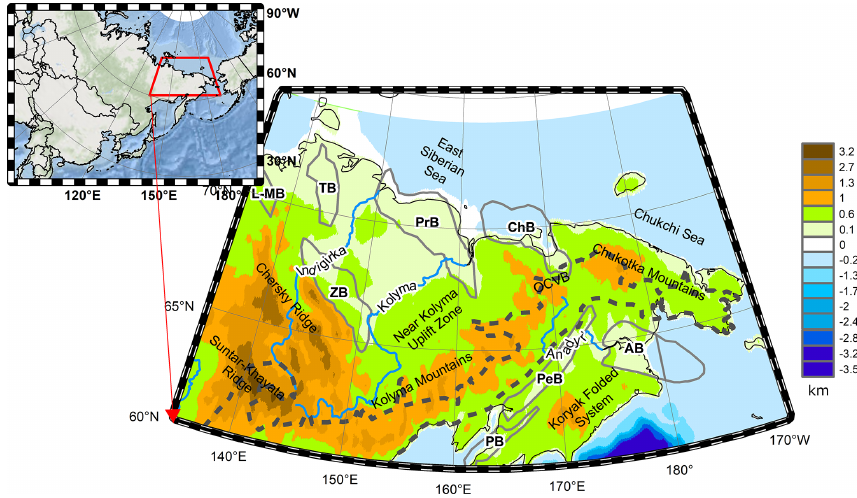
Figure 1. Topography and bathymetry of the study area. Dark grey contours represent positions of sedimentary basins. The basin captions are in bold. The dashed line indicates the OCVB continental borders. Here and in all subsequent maps the following abbreviations are used to denote the following sedimentary basins: L-MB – Laptev–Moma Basin; ZB – Zyryanka Basin; PrB – Primorsk Basin; TB – Tastakh